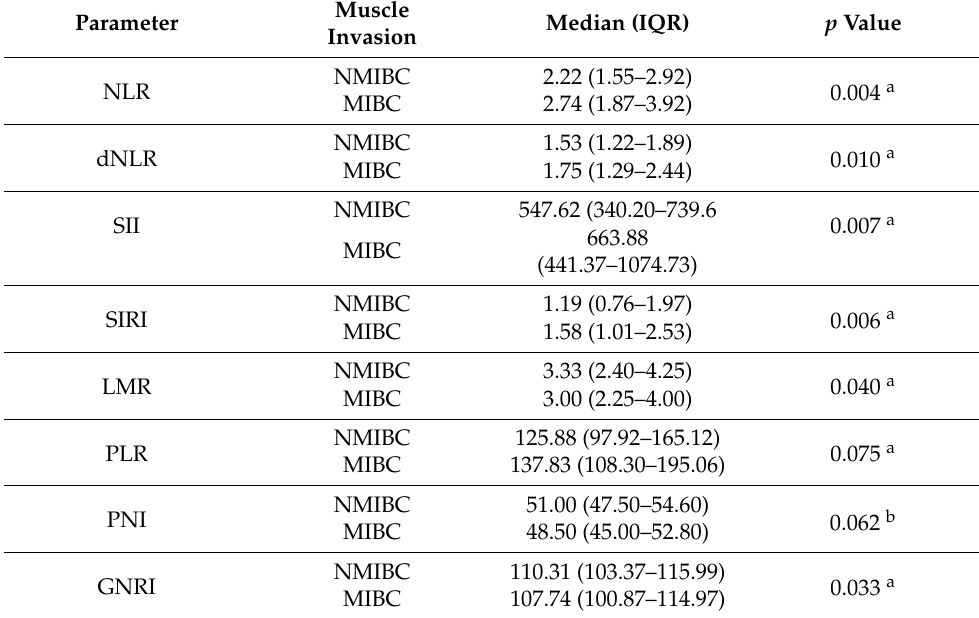
Table 4. Associations of inflammatory and nutritional parameters with muscle layer invasion.